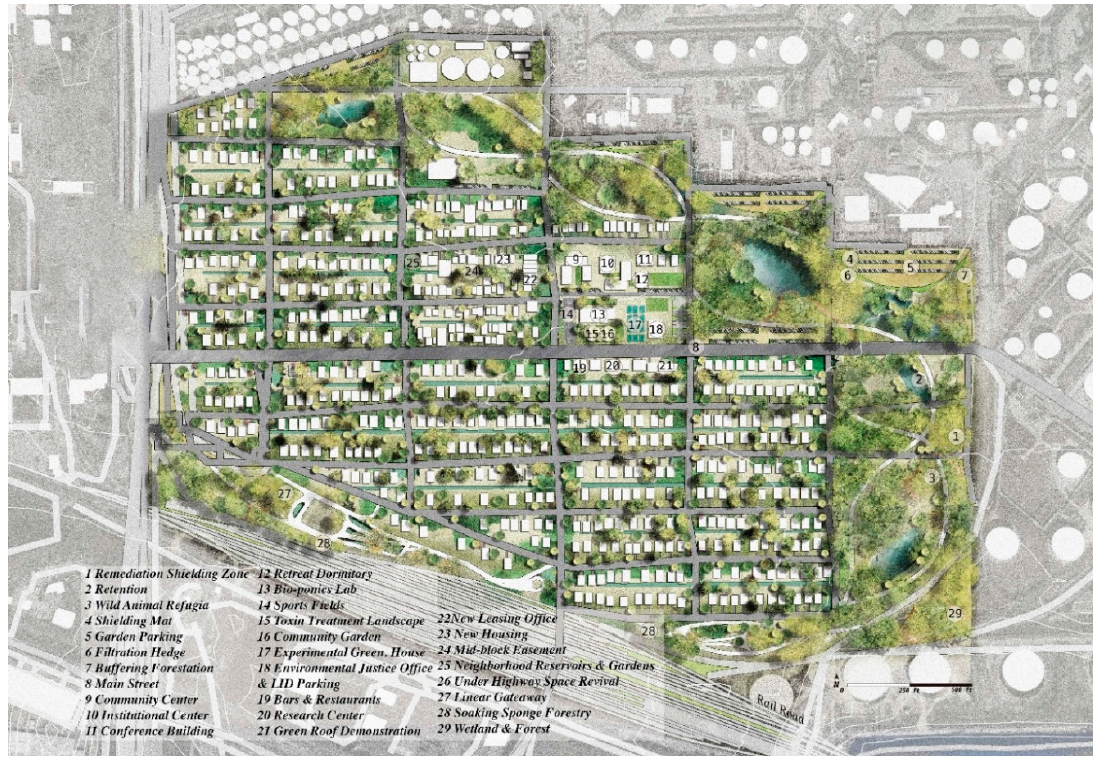
Figure 4. Master plan developed through deep engagement for Manchester neighborhood.